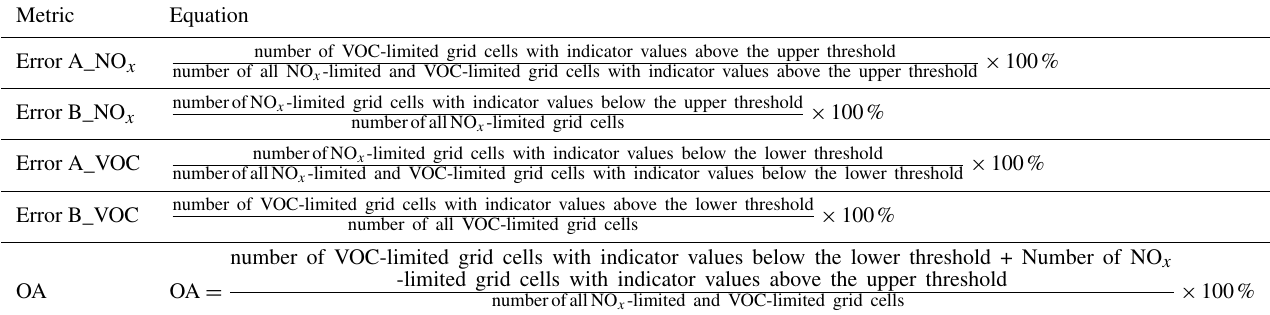
Table 2. Metrics of the indicator performance evaluation provided in Ye et al. (2016). Metric